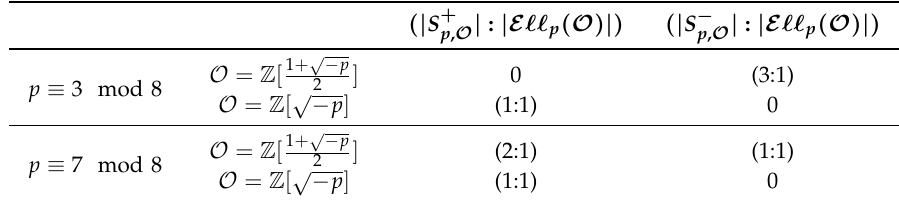
Table 3. ([14]) The ratio of the number of Montgomery ± coefficients to the number of F p -isomorphism classes of supersingular elliptic